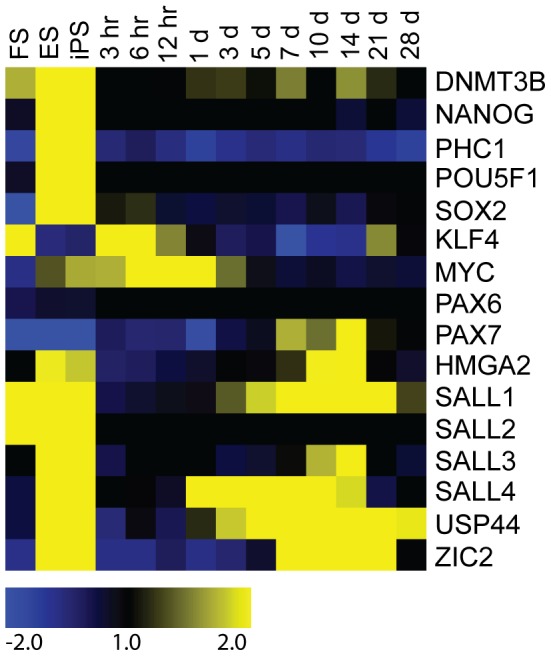
Expression of embryonic and adult stem cell genes in ES, iPS, FS, and blastemas.All samples are ratioed to the time zero axolotl juvenile time course control. While ES and iPS cells show upregulation of a variety of stem cell genes including the key ES transcription factors POU5F1 and NANOG, the axolotl blastemas do not show upregulation of POU5F1, SOX2, and NANOG, but do show upregulation of adult stem cell markers (such as SALL4 and HMGA2). Note the burst of oncogenes (KLF4, MYC) early in the time course and the upregulation of adult stem cell genes later in the time course.